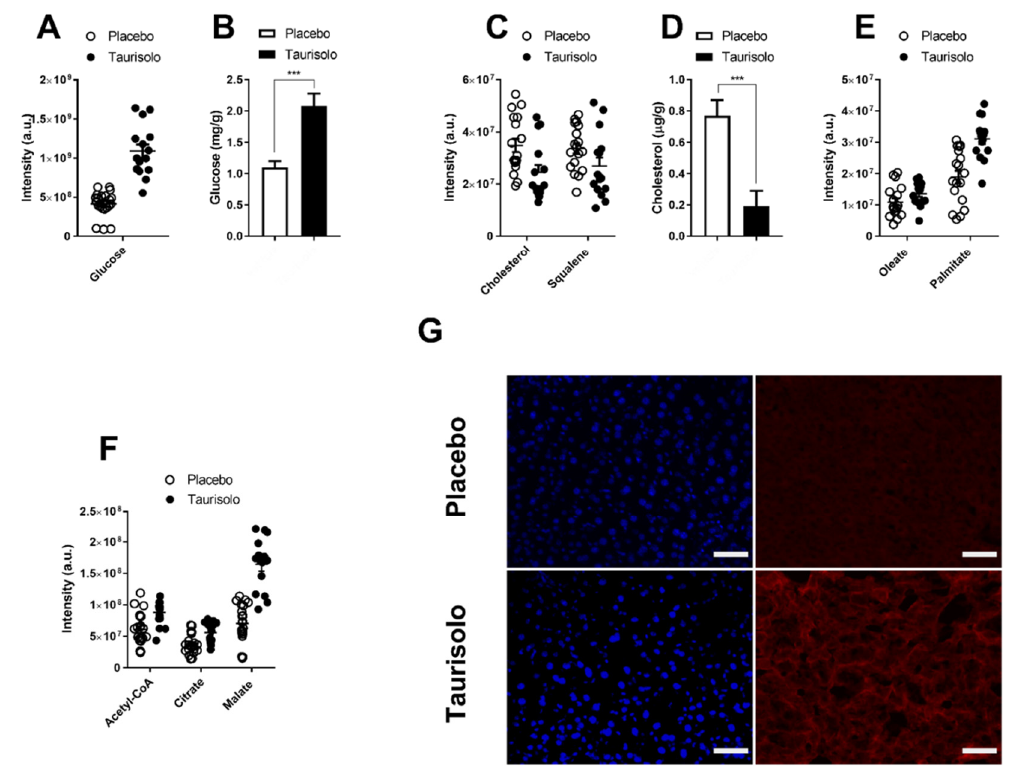
Figure 2. Taurisolo shifts mice liver metabolism toward mitochondrial respiration. ( A – F ) Metabolomic profiling of liver biopsies excised from mice fed High Fat Diet (HFD) and receiving Taurisolo (black dots) or Placebo (white dots) for 4 weeks (see also Table 2). Each dot represents the mass spectrometry intensity of the indicated metabolites as measured by FT-ICR-MS. In ( B , D ), mass spectrometry data for glucose and cholesterol were confirmed by measuring their intracellular concentration (using enzymatic reactions) in Taurisolo (black bars) or Placebo (gray bars) groups. (Data are representative of n = 6 triplicated measurements, shown is mean ± s.e.m. Two-way ANOVA and Bonferroni post-test analysis were performed; *** p < 0.001;). ( G ) The fluorescent emission of Mitotracker CMX-ROS (red channel) was here used to show the increase in mitochondrial membrane potential induced by Taurisolo in murine livers. Liver biopsies collected from mice treated with Taurisolo or placebo were incubated ex-vivo with Mitotracker CMX-ROS. UPPER PANEL: A faint fluorescence emission of the probe (red channel) is detectable in the hepatocytes of the placebo group. LOWER PANEL: Increased fluorescence emission of Mitotracker CMX-ROS in hepatocytes of the Taurisolo group. DAPI (blue channel) stains cell nuclei. In G, scale bars correspond to 50 µ m.